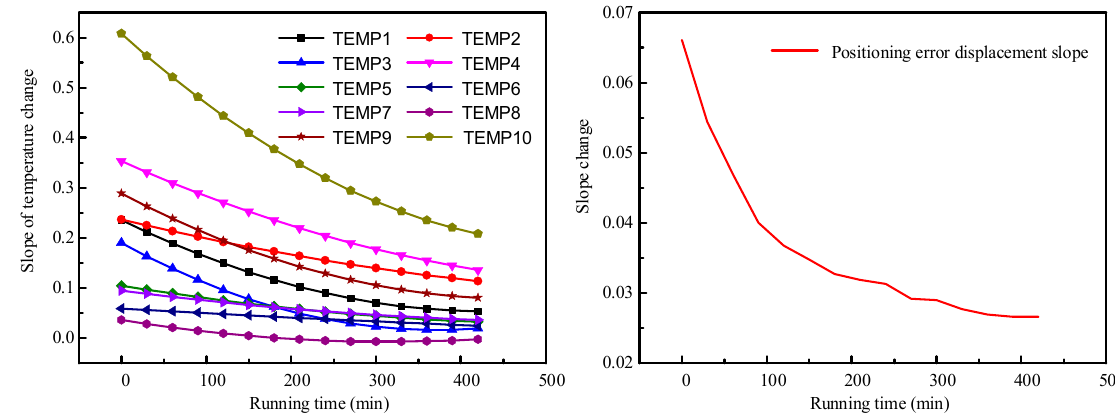
Figure 11. Temperature slope change versus displacement slope change graph. Therefore, the slope of the slope of the primary fitting matrix of the positioning error on the X-axis can be considered for the initial screening of the gray correlation with the variation in a temperature rise of the ten temperature sensors to establish the degree matrix of the gray correlation. Using Dunn’s correlation degree, i.e., 1 𝛾(𝑦, 𝑥 ) = (cid:3533) 𝑟(𝑦 , 𝑥 ) (cid:3036) (cid:3038) (cid:3036)(cid:3038) 𝑛 In Equation (4), y represents the slope of the geometric error displacement change, x i represents the i -th temperature measurement point, y k represents the slope of geometric error displacement change, x ik represents the k -th observation of the changing trend of the i -th temperature measurement point. γ ( y , x i ) is the gray correlation between the slope of the geometric error displacement change and the changing trend of the i -th temperature measurement point, averaged from the correlation γ ( y , x i ) of each observation. γ ( y , x i ) is calculated as follows: